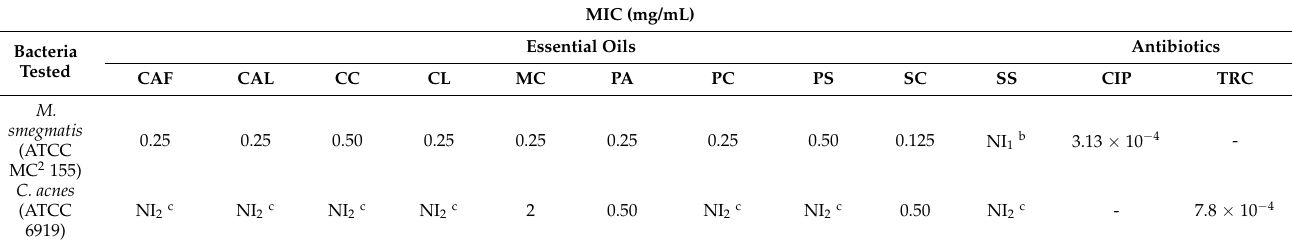
Table 1. Antimycobacterial and anti-acne activities of EOs. MIC